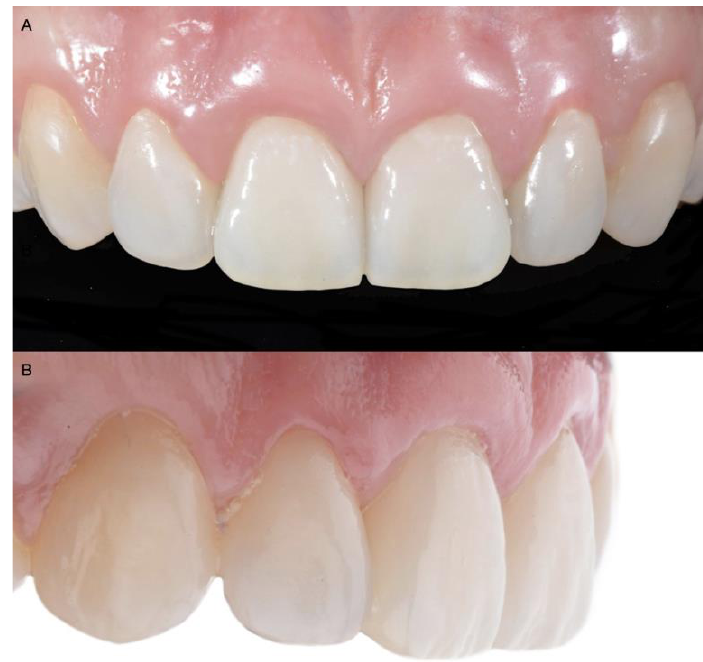
Figure 10. Five-year follow-up: ( A ) Frontal view; ( B ) Lateral view.